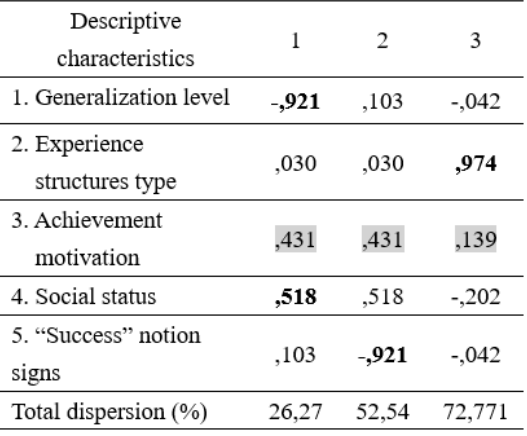
Table 1. Components of the success mental representations factor structures in group 1